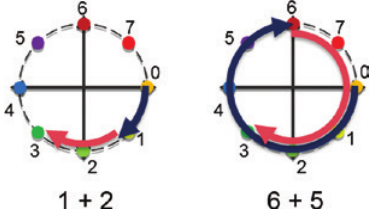
Figure 19: Half-phase add transformed into encoded carry